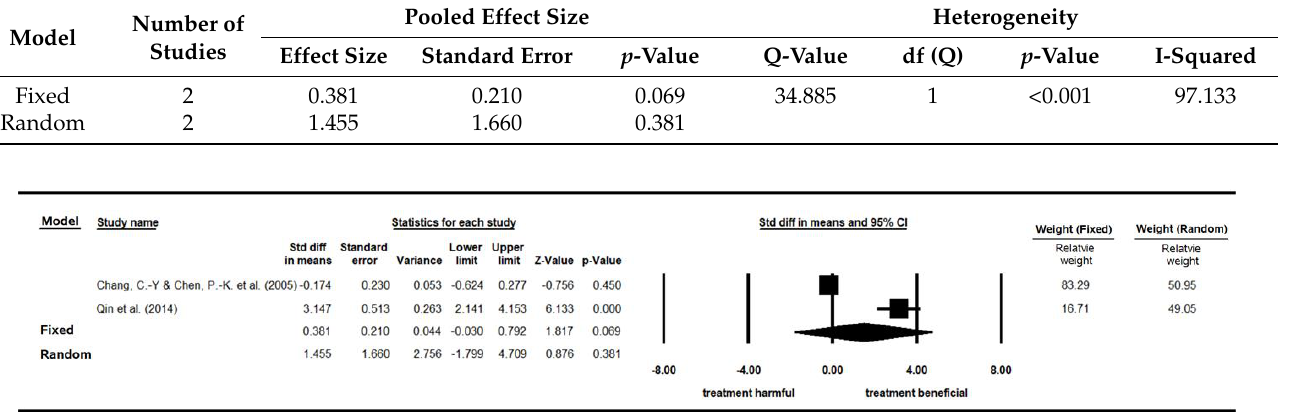
Figure 4. Forest plot of studies on the influence of indoor plants on EEG β waves [72,81].